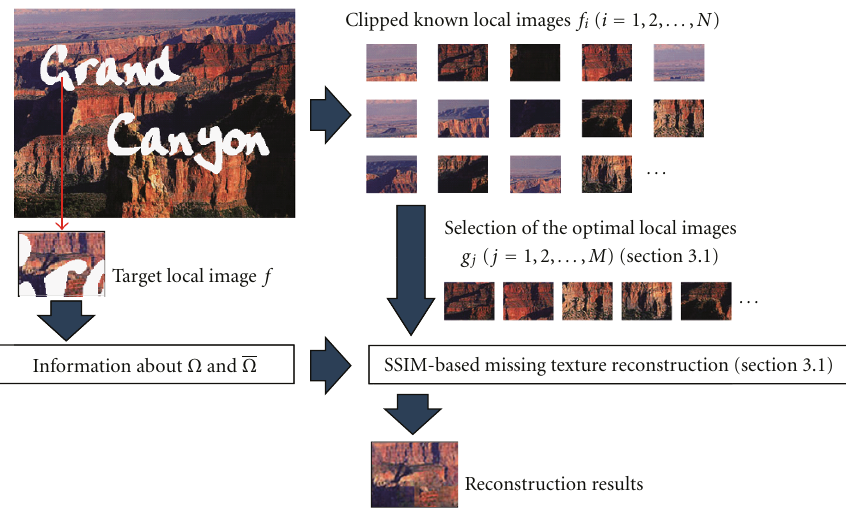
Figure 1: Outline of the proposed method including a perceptually optimized